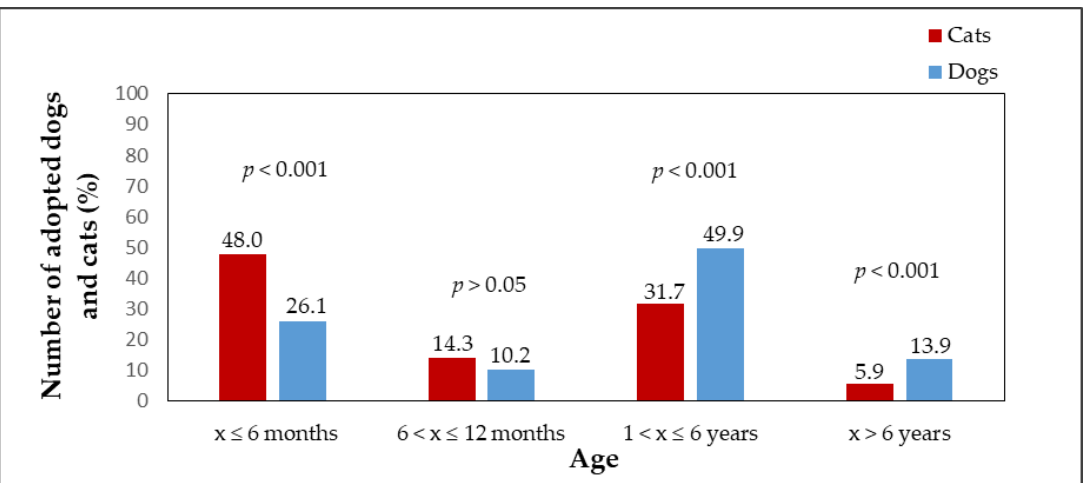
Figure 3. The percentage of adopted dogs (n = 1051) and cats (n = 356) in four age categories, x = age of an animal.